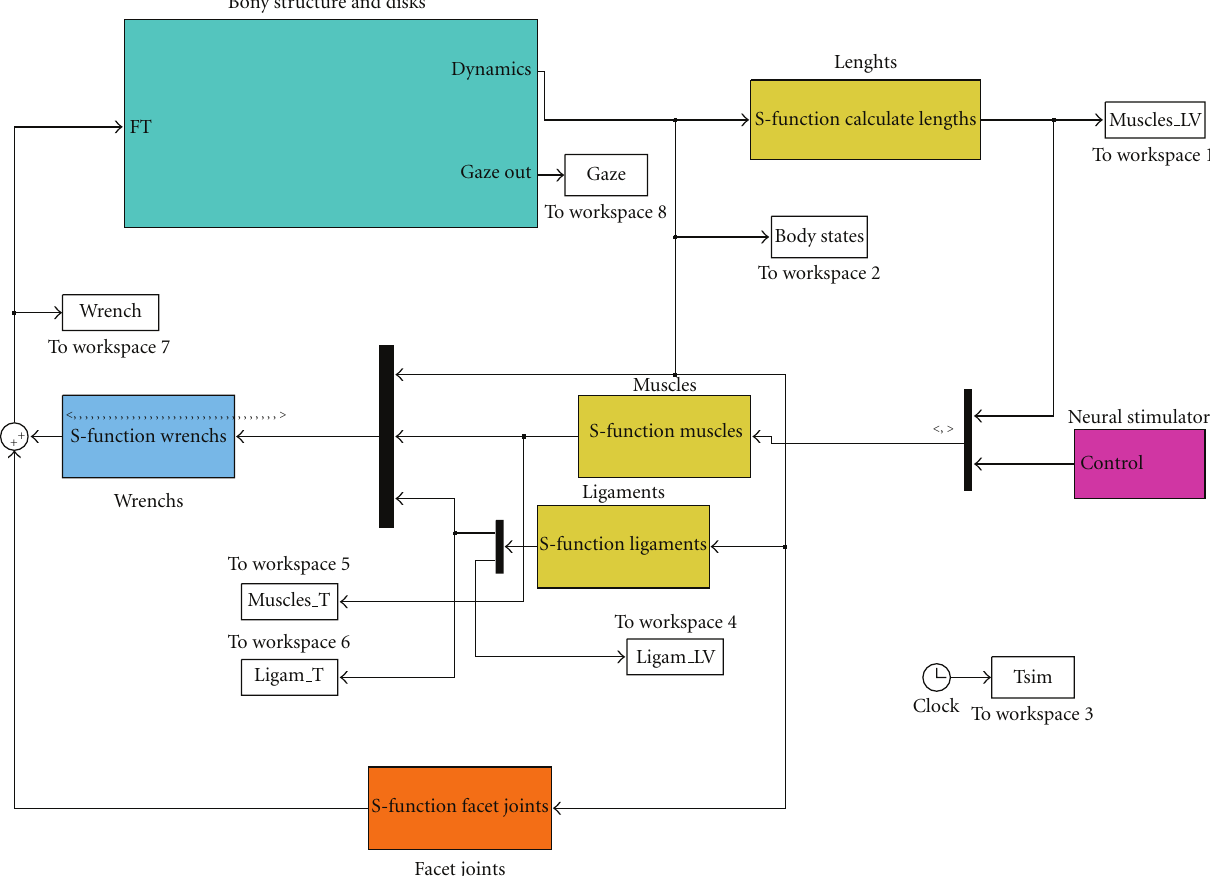
Figure 4: General structure of the model in Simulink. Note that the bony structures and disks dynamics receive as inputs the net wrenches (moment and force structures, as defined by Dumas et al. [29]) from muscles, ligaments, and facet joints. Muscles receive the neural stimulus from an independent controller to allow the model serve as a testbed for neural control of fast gaze